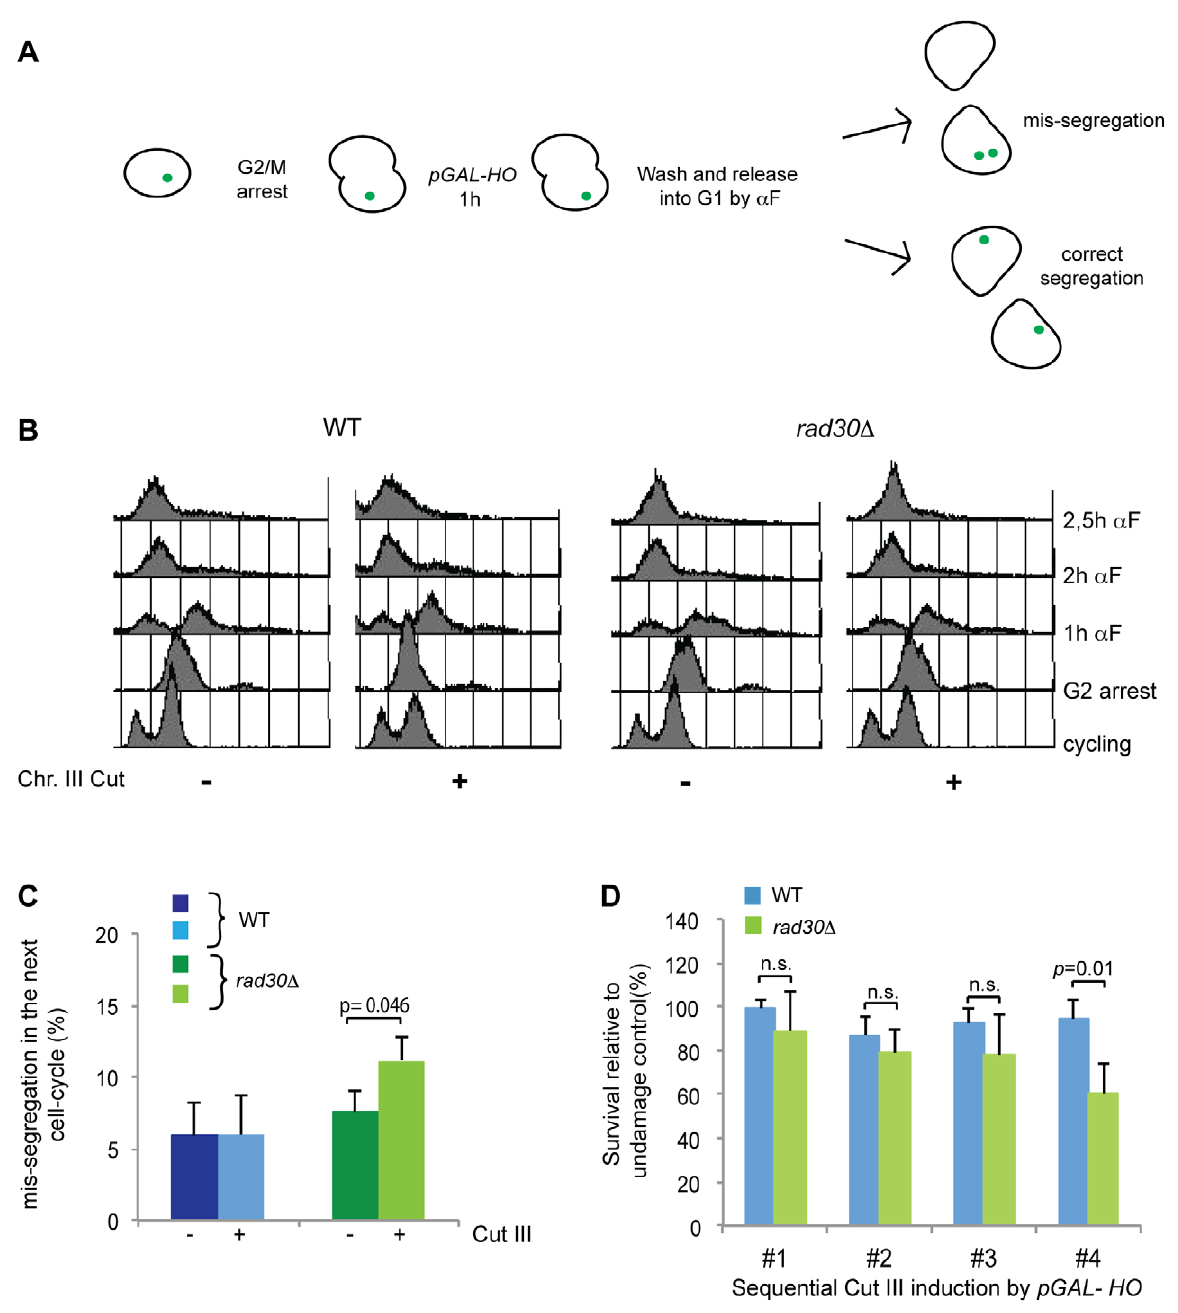
Figure 8. DI-cohesion is required for correct chromosome segregation. (A) Experimental setup of the chromosome segregation assay. Logarithmically growing cells were arrested in G2/M by addition of nocodazole. A DSB was induced at the MAT locus on Chr. III by pGAL-HO . After 60 min, cells were washed and released from the G2/M arrest into fresh medium containing alpha factor ( a F). When 90–100% of the cells had reached G1, samples were scored for chromosome segregation using the TetR-GFP/Tet-O system on Chr. V. (B) FACS profiles showing the G2/M arrest, the subsequent release and the final arrest in G1, in WT and rad30 D strains in the presence or absence of DSB as indicated. (C) The graph shows a comparison of the percent of mis-segregated chromosome V in the absence and presence of DSB on Chr. III, in WT and rad30 D strains as indicated. The error bars show SD values calculated from $ three individual experiments. Significant difference is indicated by actual p value (students t-test ). (D) Survival after repeated rounds of DSB induction by expression of pGAL-HO in G2 arrested cells of indicated genotypes. Chr. V. Presence of a single copy of the HO cut-site at the desired introduced into the LEU2 locus of smc1-259 cells as described [21]. position was confirmed by PCR. Introduction of plasmids into For further details on strains used for DI-cohesion detection see yeast strains was done using standard yeast transformation below and Figure 1. To generate strains containing the rad30 - F627A, F628A and rad30-D570A mutations we used a two-step protocols. SMC1-myc 13 was cloned by PCR and inserted down- stream of the GAL1-10 promoter in the YIPlac128 vector [59], and PCR-based method [60]. The ORF of RAD30 was amplified from